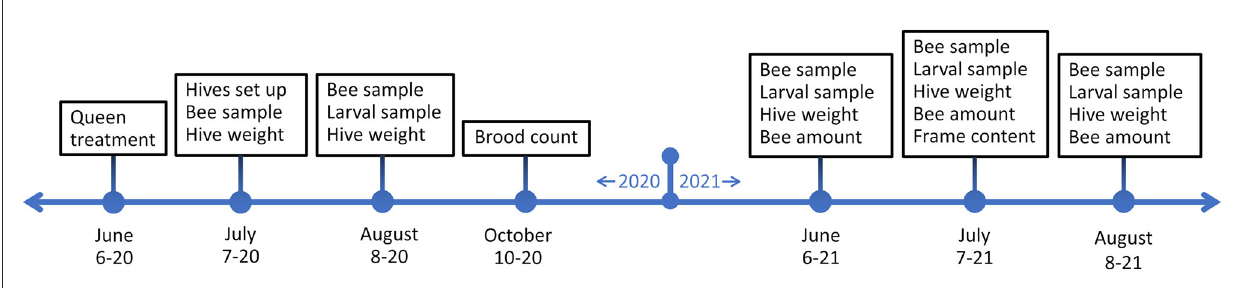
FIGURE2 Experiment timeline and schedule of sampling times and hive measurements.